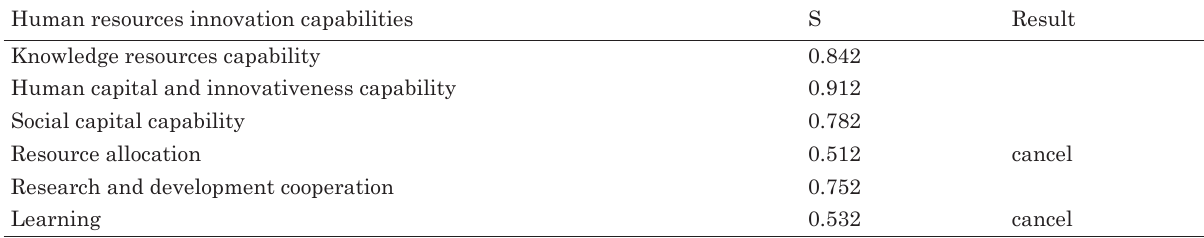
Table 5. Criteria for human resources innovation capabilities Human resources innovation capabilities